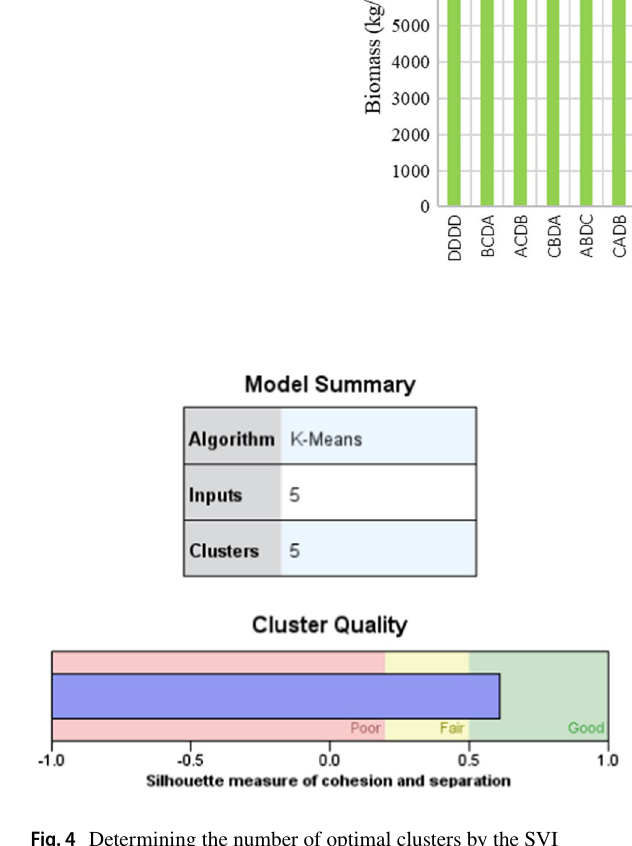
Fig. 4 Determining the number of optimal clusters by the